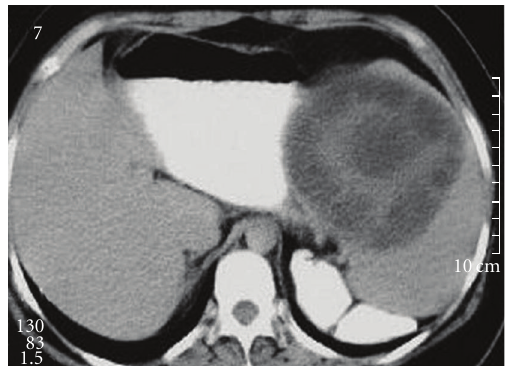
Figure 2: Axial CT with oral and IV contrast shows an unenhanced hypodense mass with well-defined borders in the anterior part of the spleen. Multiple round daughter cysts are seen peripherally within the lesion.